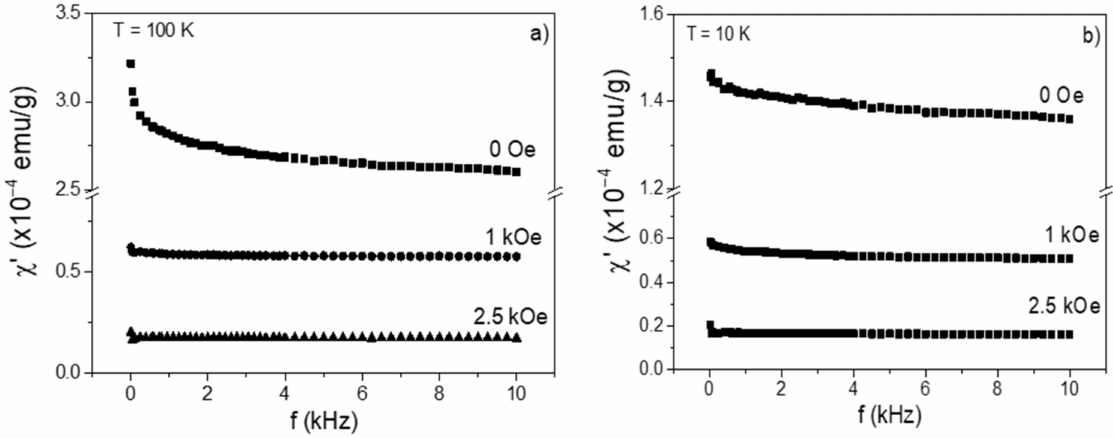
Figure 6. Frequency dependence of the χ (cid:48) (T,f) component recorded at 100 K ( a ) and 10 K ( b ) under selected DC bias